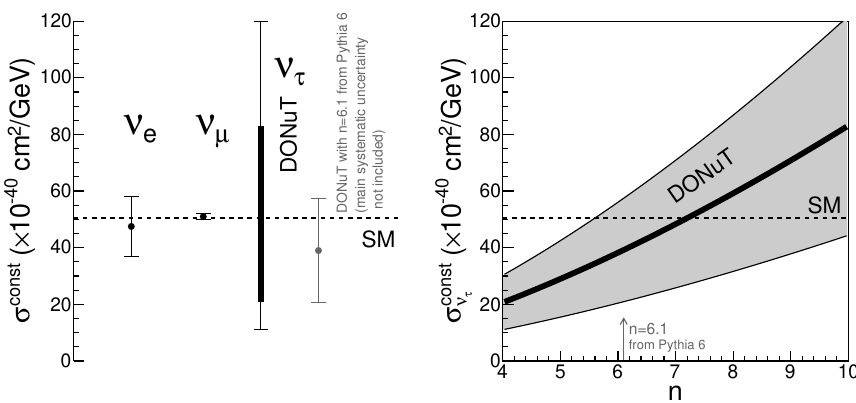
Figure 1 . Left: (cid:23) , (cid:23) averaged energy independent cross section of the three neutrino (cid:13)avors ([21] for (cid:23) e , [22] for (cid:23) (cid:22) , and for (cid:23) (cid:28) [7]). A dash horizontal line indicates SM prediction according to Lepton Flavour Universality. For the DONuT’s result, since there is no measurement of the parameter n concerning the D s double di(cid:11)erential production cross-section (eq. (1.1)), the value is plotted in the empirical range of a parameter n given by [7] as in the right plot. Right: the cross section result by the DONuT experiment, as a function of the parameter n [7]. The arrow shows the value of n estimated from PYTHIA simulation (version